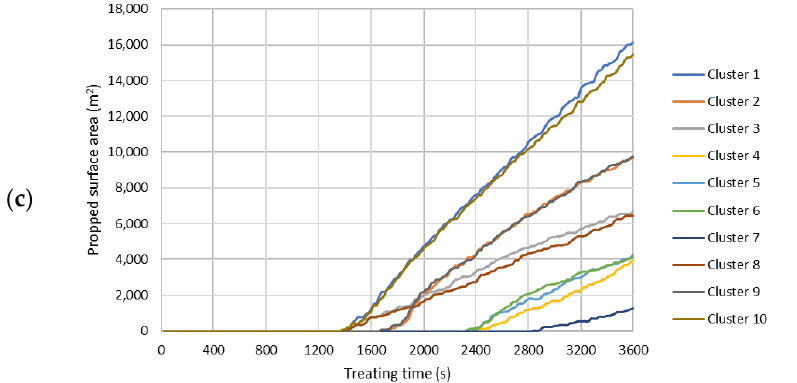
Figure A7. Propped fracture surface area of each cluster during the hydraulic fracturing treatment.